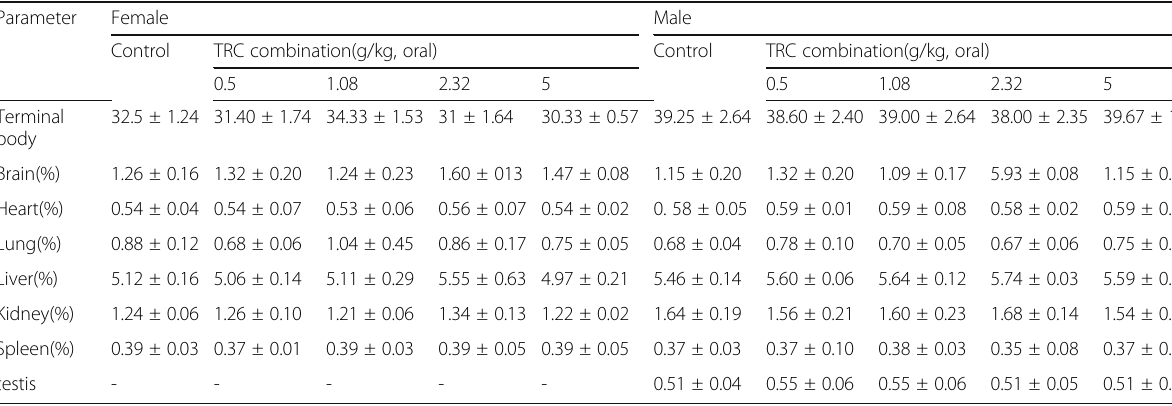
Table 7 The relative organ weights (AOT study)